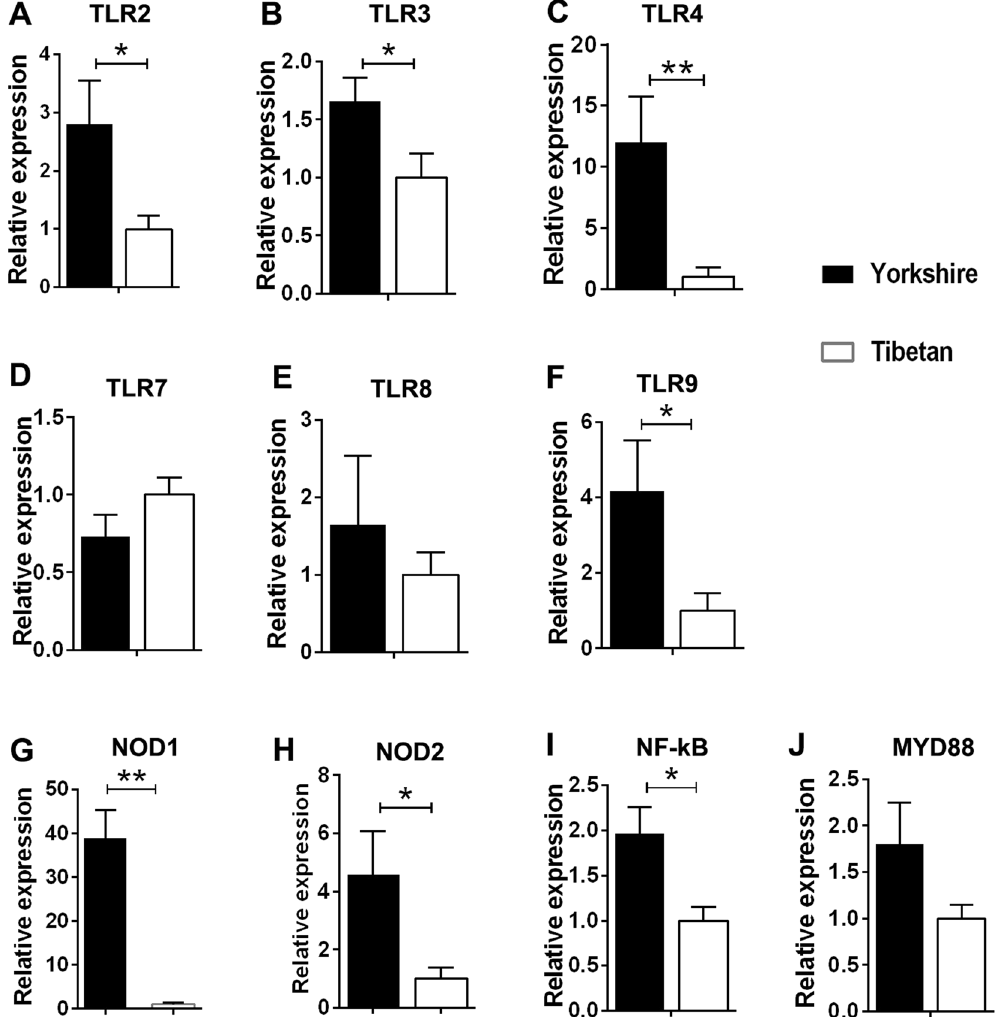
Figure 3. Relative quantities of mRNAs encoding TLRs, NLRs and associated molecules in the intestinal tissues of the Yorkshire and Tibetan pigs. Total RNA was prepared from the colon tissues of these two pig strains as described in the “Materials and Methods”. Relative mRNA expression was quantified by qRT-PCR. The results are presented as the mean ± the SEM. Statistical significance was assessed by performing a Student’s t-test. * P < 0.05; ** P < 0.01. Each n =